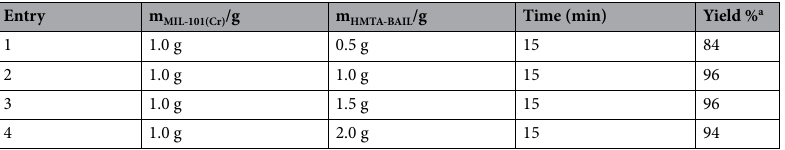
Table 2. Optimization of the loading amounts of HMTA-BAIL for the synthesis of 4c . Reaction conditions: 4-bromobenzaldehyde (1 mmol), 1 H -tetrazole-5-amine (1 mmol), and 3-cyanoacetyl indole (1 mmol). a Isolated